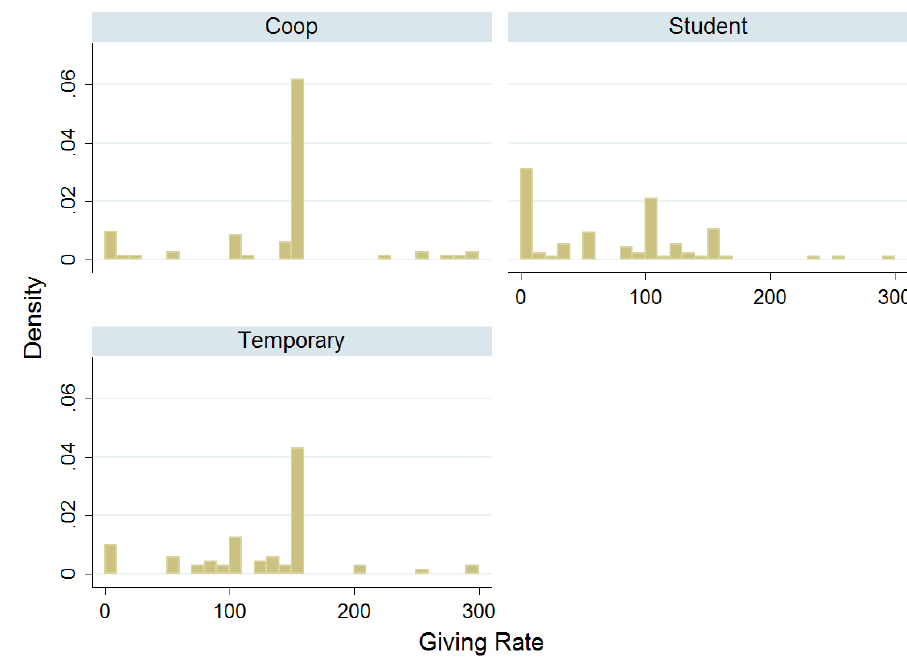
Figure A1. Dictator Game: distribution of